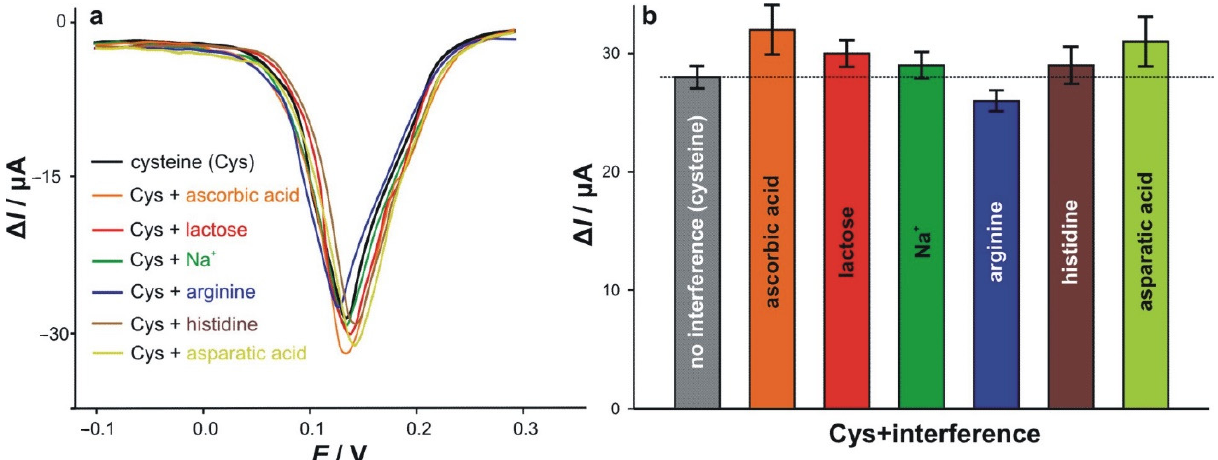
Figure 8. ( a ) The DPV responses of cysteine in presence of potential interference; ( b ) Interference signal of Cys with AA, lactose, Na + , Arg, His and Asp.